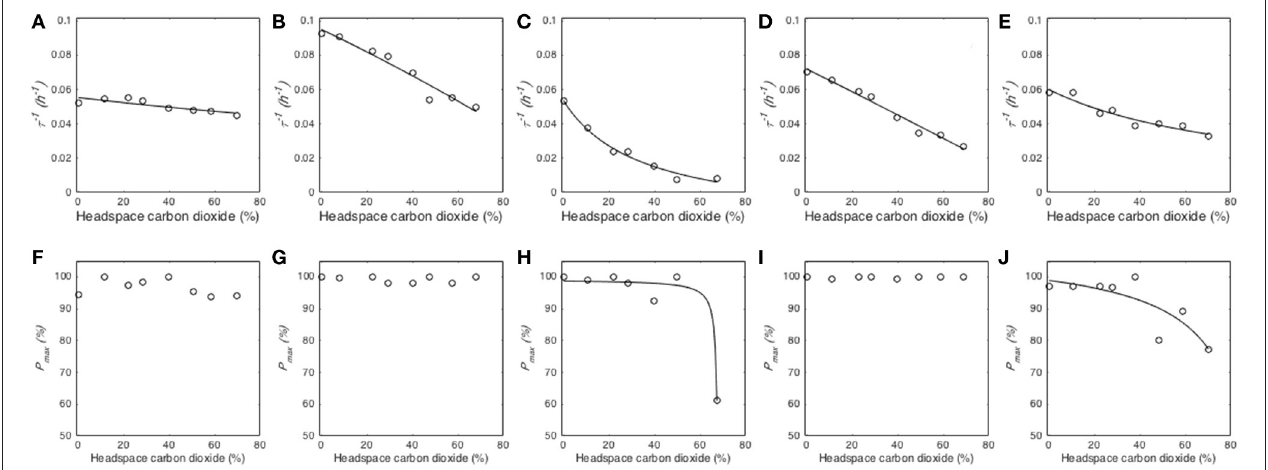
FIGURE 4 | Influence of CO 2 partial pressure (%) in headspace on the reciprocal of median germination time τ − 1 ( h − 1 ) and maximum germination percentage P max (%) of Paecilomyces niveus UBOCC-A-11024 (A,F) , Mucor lanceolatus UBOCC-A-109153 (B,G) , Penicillium brevicompactum UBOCC-A-110007 (C,H) , Penicillium expansum UBOCC-A-110032 (D,I) and Penicillium roqueforti UBOCC-A-113022 (E,J) on PDA medium (pH 4.2, 0.980 a w ) at 25 ◦ C. Observed parameters (open circle), model fitted with Equation (4) (solid line).